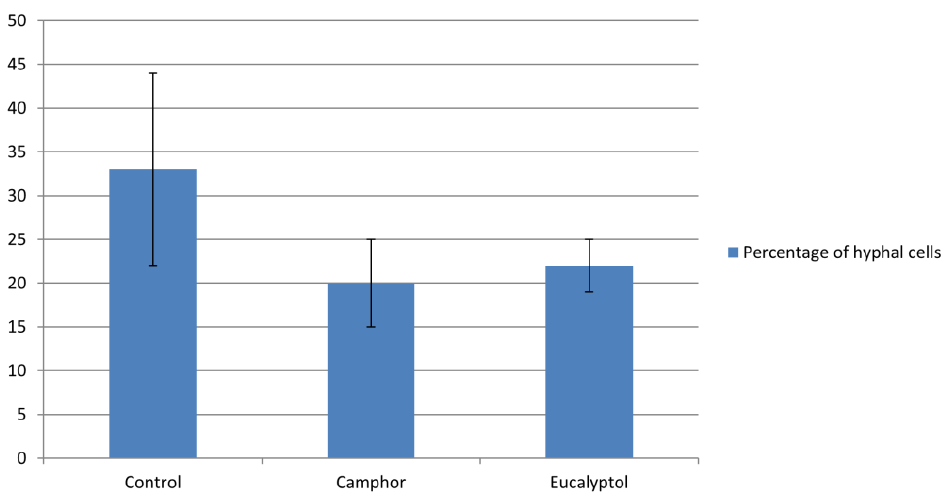
Figure 3. The number of hyphae and germ tubes was determined 4 h post treatment of Candida albicans cells with compounds and the percentage of hyphal cells was calculated. Values represent means ± SD of three replicates.